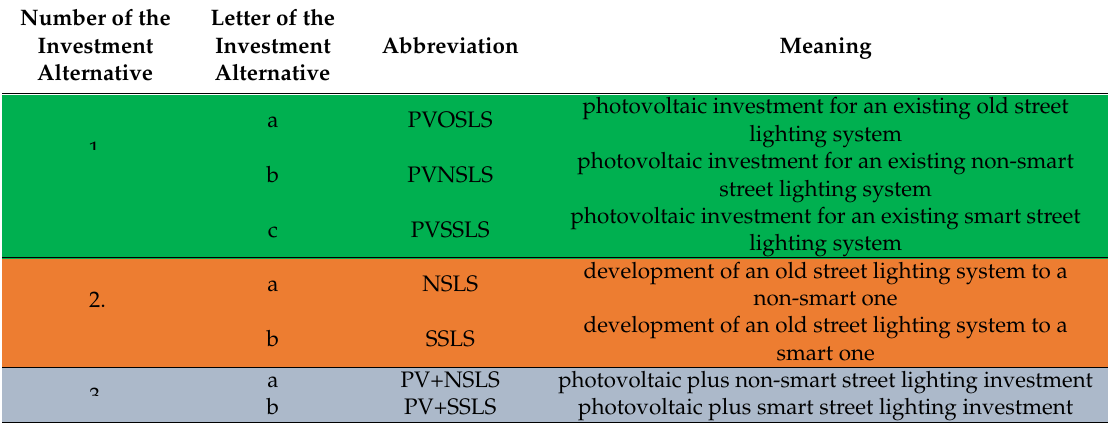
Table 1. The abbreviations for the investment